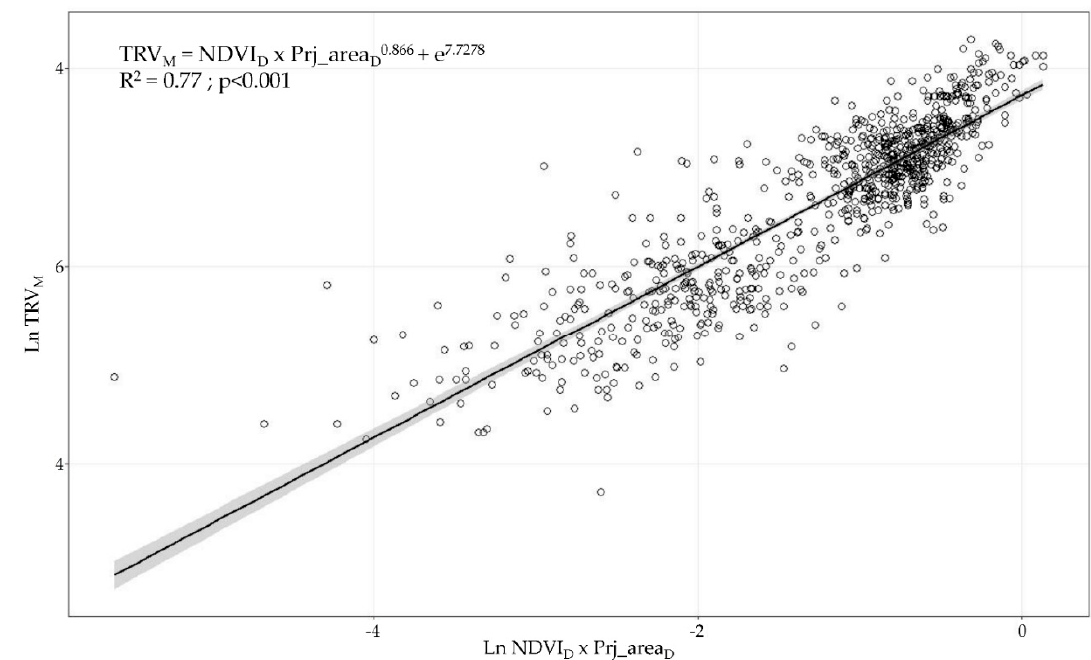
Figure 7. Linear regression model (R 2 = 0.77, p < 0.001) evaluating relationship between Ln TRV M and Ln NDVI D × Prj_area D. Grey band shows 95% confidence interval.